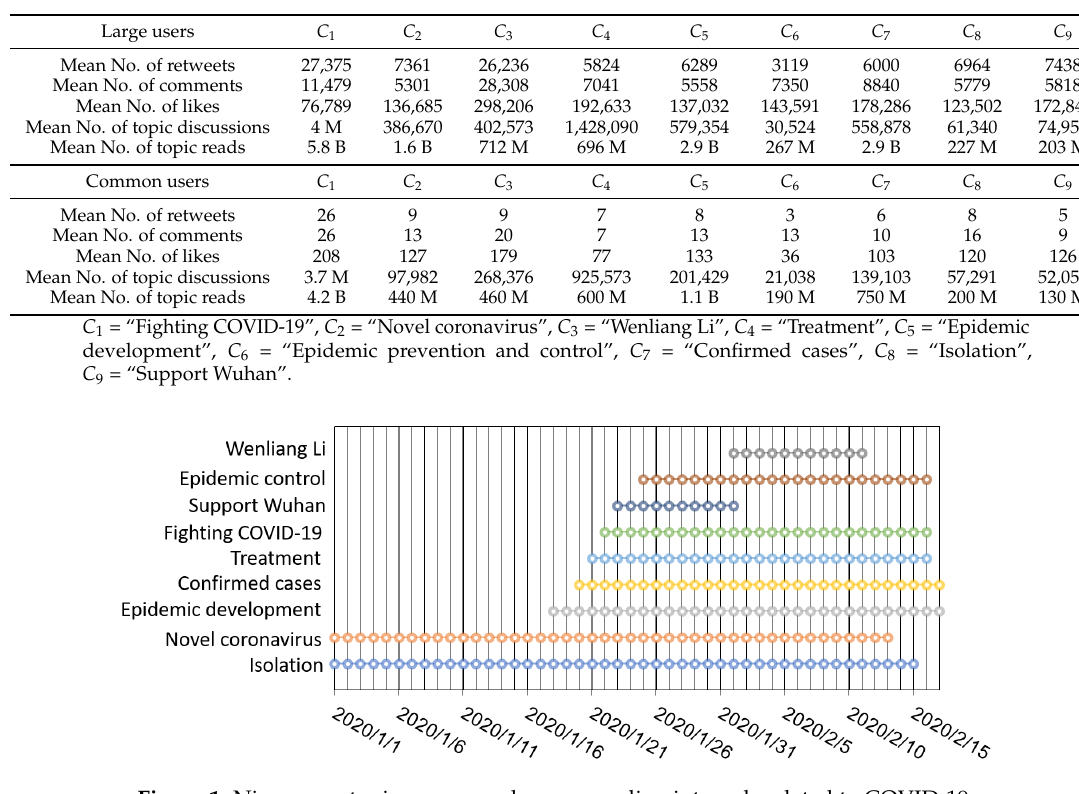
Figure 1. Nine super topic groups and corresponding intervals related to COVID-19.